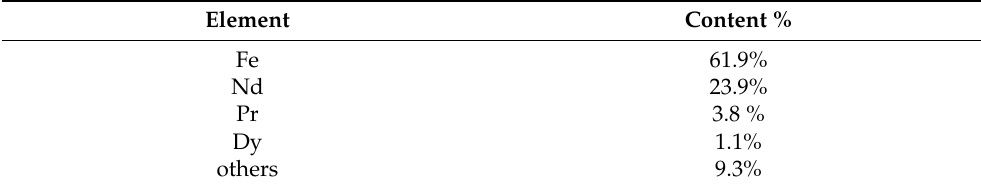
Table 2. Average chemical composition of NdFeB magnets used in mobile